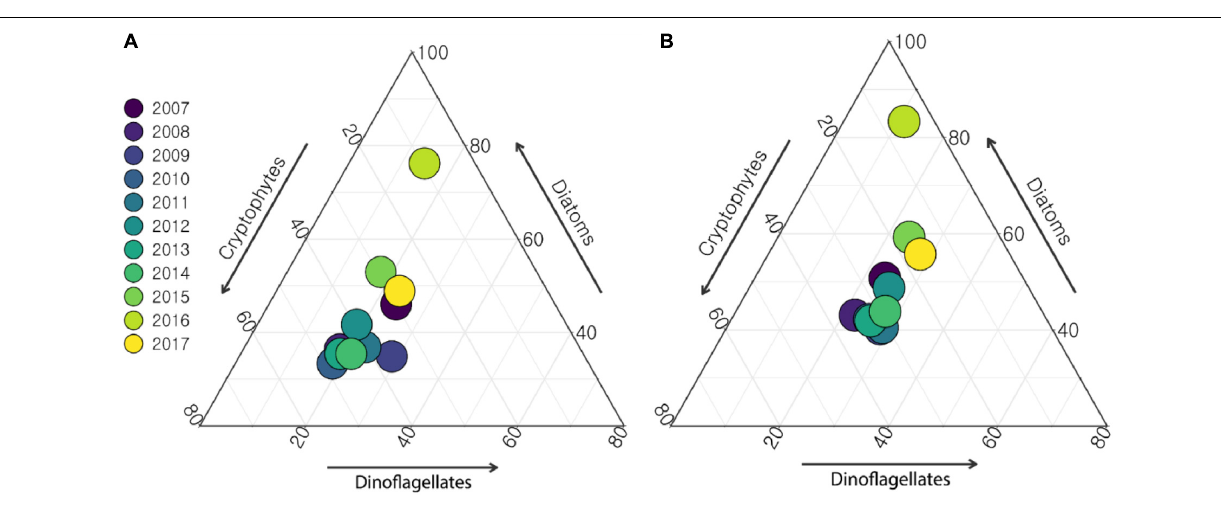
FIGURE 4 | Relative abundance of the major phytoplankton groups including cryptophytes, diatoms, and dinoflagellates. Abundance in the surface layer (A) and abundance in the bottom layer (B)